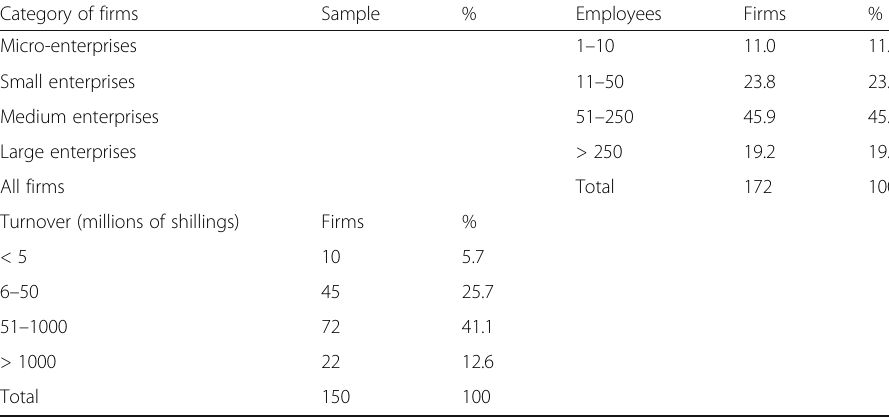
Table 2 Profile of the respondents in sample enterprises Category of